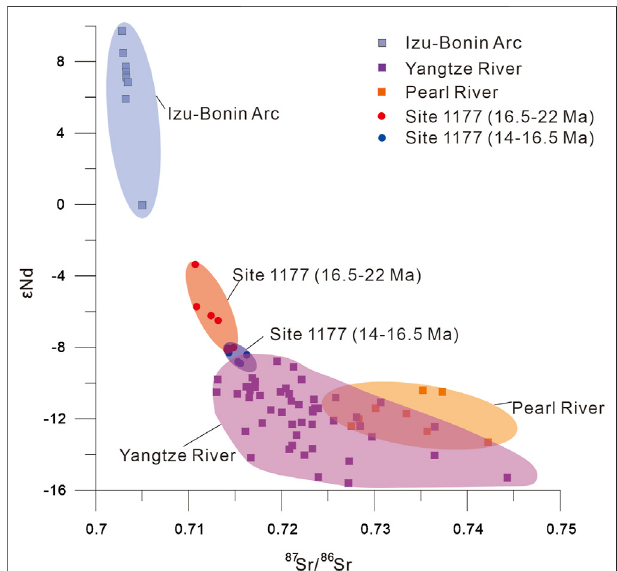
FIGURE 4 | The plot of 87 Sr/ 86 Sr and ε Nd for sediments from ODP Site 1177.Datafor sedimentsfrom the Pearl River (Liu Z.et al.,2007), theYangtze River (Yang et al., 2007; Meng et al., 2008), and the IBA (Tollstrup et al., 2010) are also shown for